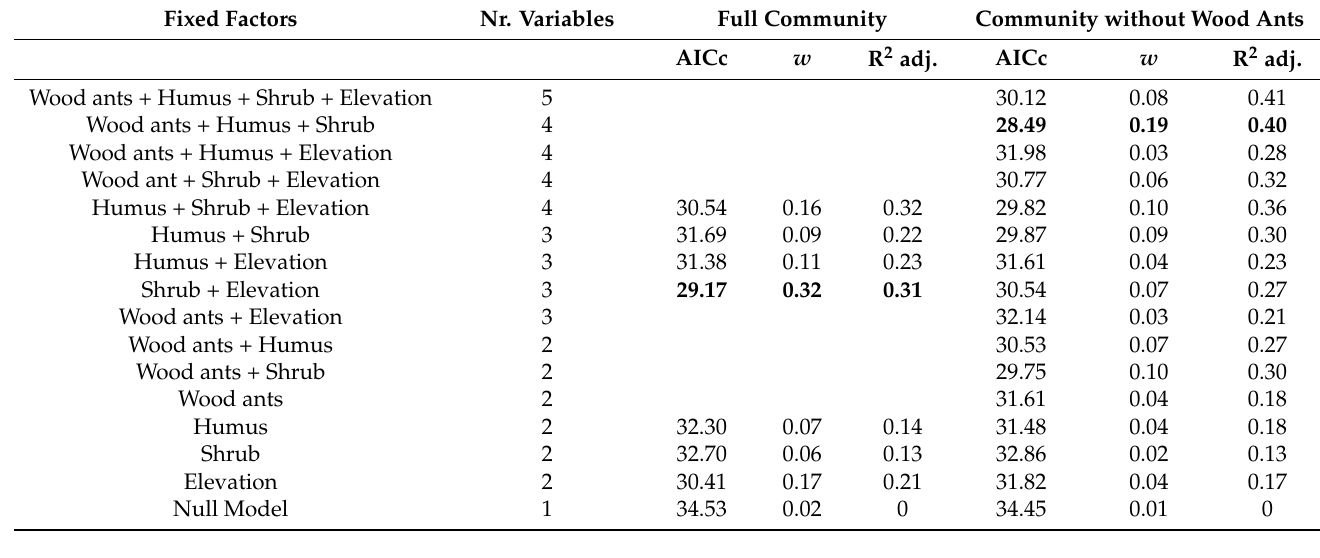
Table 1 . Model selection results for distance-based redundancy analysis ( capscale() function in R package vegan) of ant assemblage composition, first for the full ant community, and additionally for the community of subordinate ant species. Three putative explanatory variables were tested with addition of the influence of wood ant abundance on the subordinate community. Mountain slope identity was always modelled as random factor to control for spatial autocorrelation. AICc defines the Akaike information criterion corrected for small sample sizes, w the Akaike weights and R 2 the adjusted explained variance. The best model is printed in bold face.